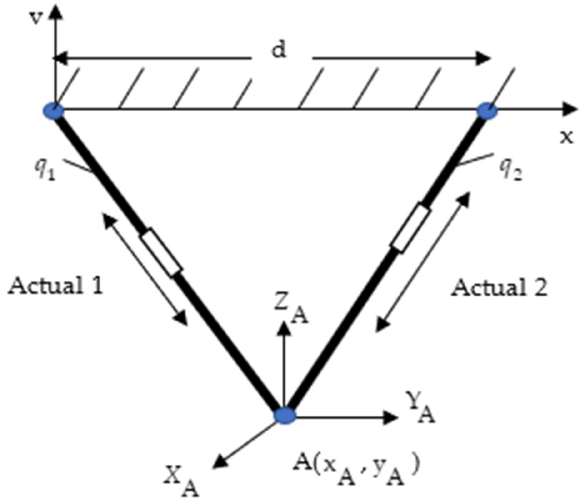
Figure 2. Frame assignment for the 2 DOF planar CKCM manipulator.